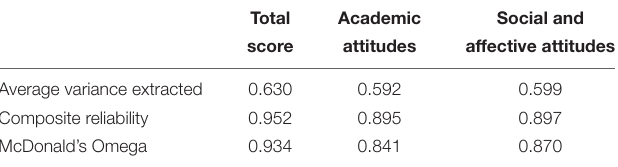
TABLE 3 | Values of AVE, CR and (cid:127) of the CACTE scores.